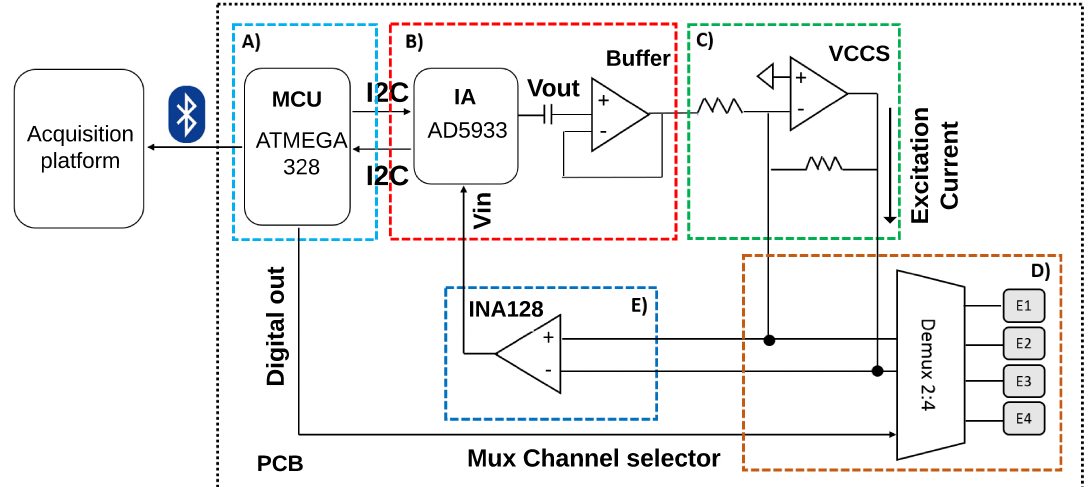
Figure 2. General diagram of the thoracic electrical bioimpedance (TEB) measurement system. ( A ) Control stage. ( B ) Generation of excitation voltage. ( C ) Conversion to excitation current. ( D ) Distribution. ( E ) Acquisition of differential